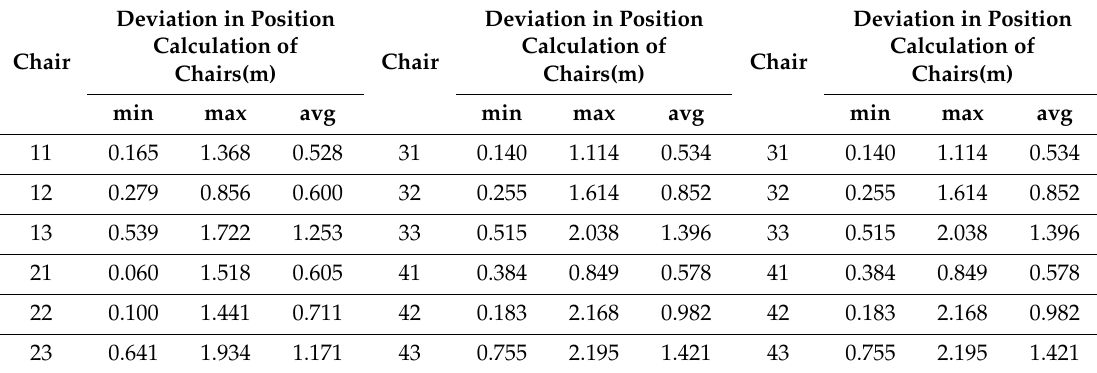
Table 1. Deviation in position calculations of chairs in the room type II.